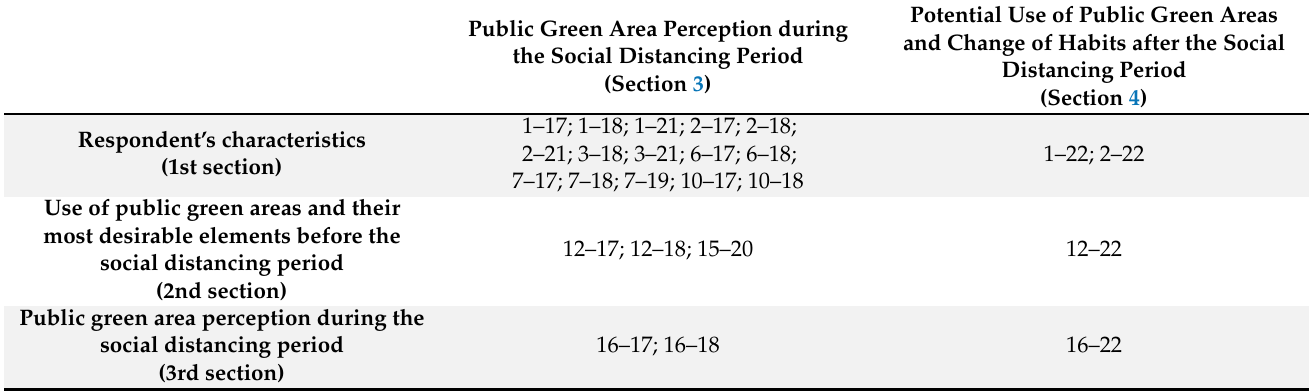
Table 2. Some of the questions selected for comparing the different sections of the questionnaire. Potential Use of Public Green Areas Public Green Area Perception during and Change of Habits after the Social the Social Distancing Period Distancing Period (Section 3) (Section